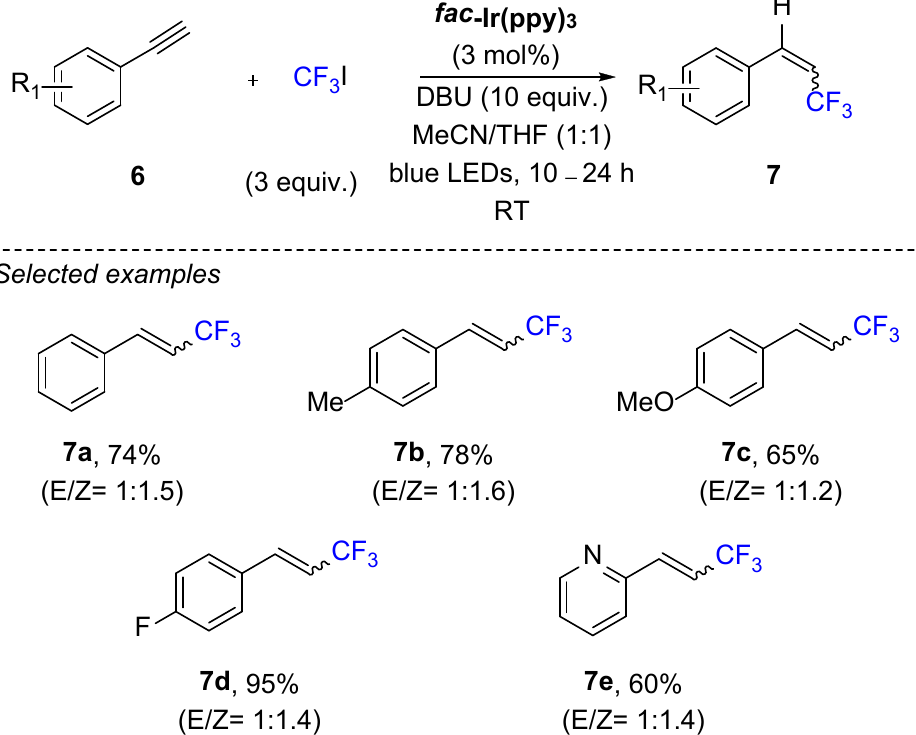
Figure 5. Hydrofluoroalkylation of alkynes developed by Cho’s